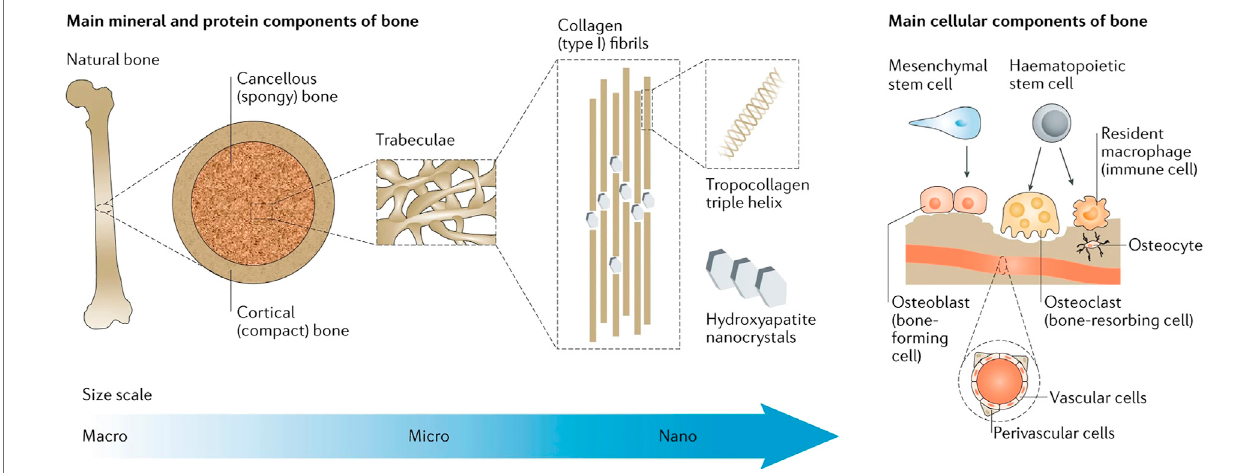
FIGURE 1 | Bone physiology for biomimicry of candidate biomaterials for bone-tissue engineering. Reproduced with permission from Koons et al.